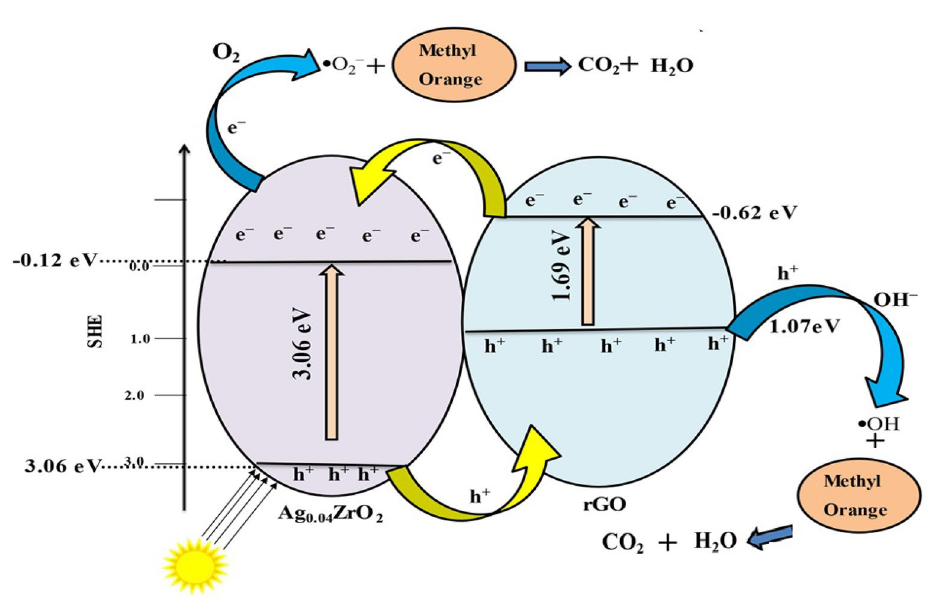
Figure 10. Mechanisms of photocatalytic degradation of MO by Ag 0.04 ZrO 2